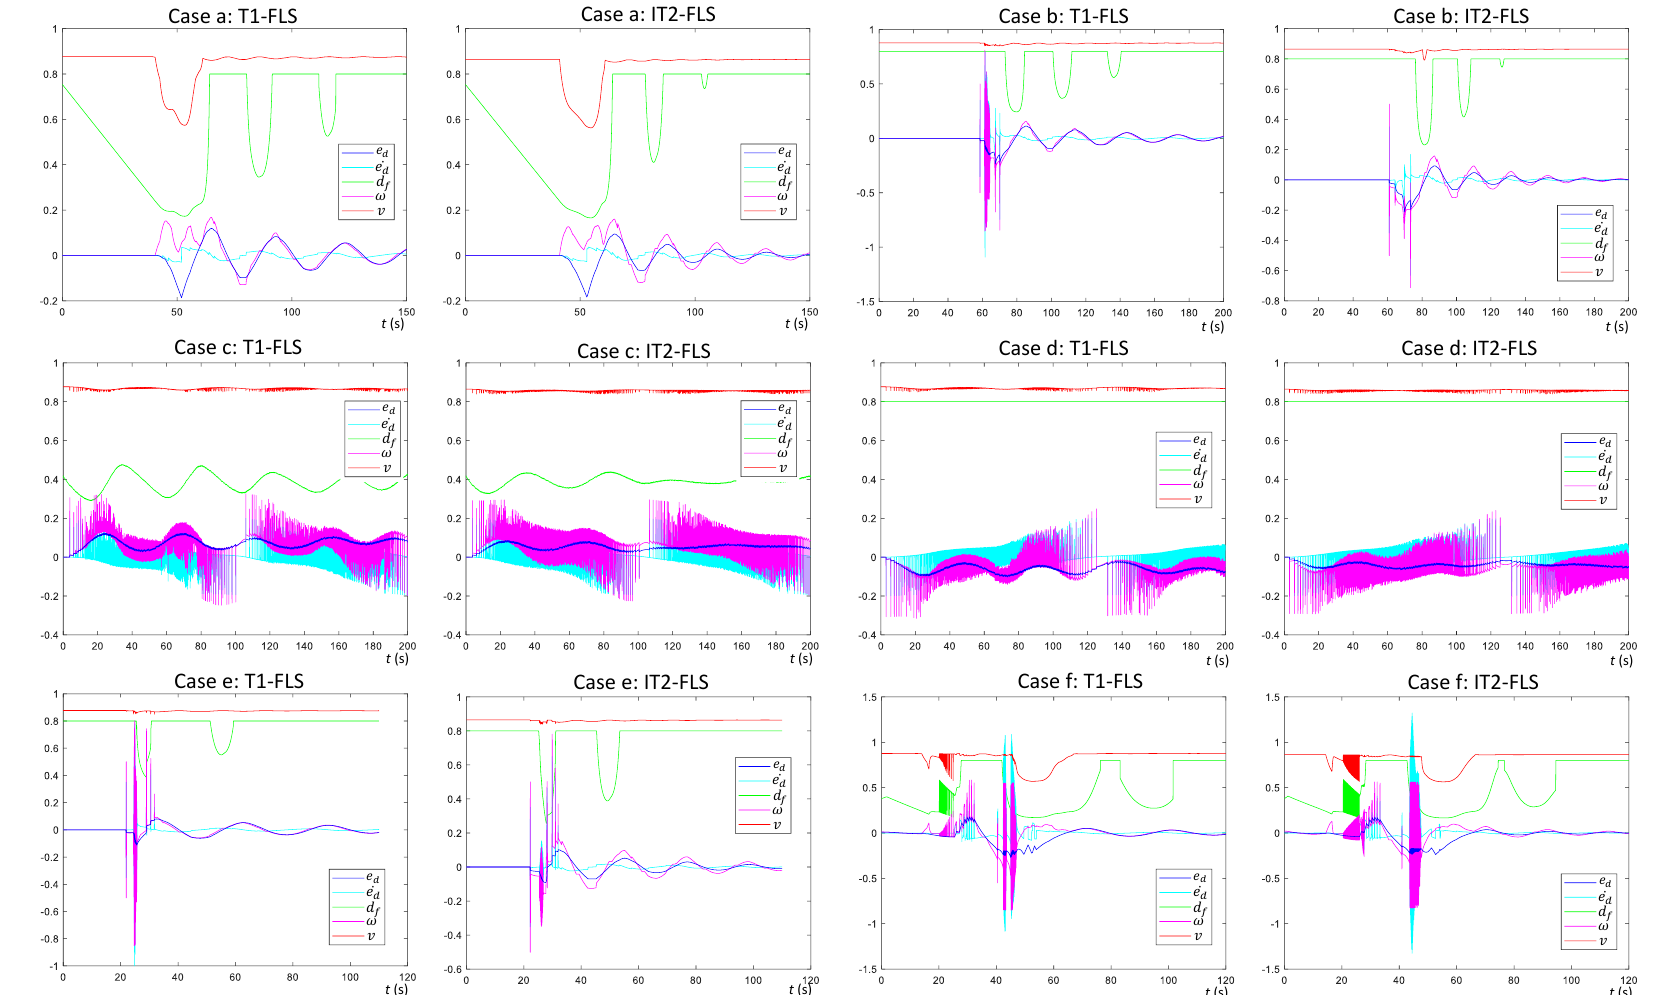
Figure 9. The variation of the inputs and outputs of the T1-FLS and the IT2-FLS during the test cases given in Figure